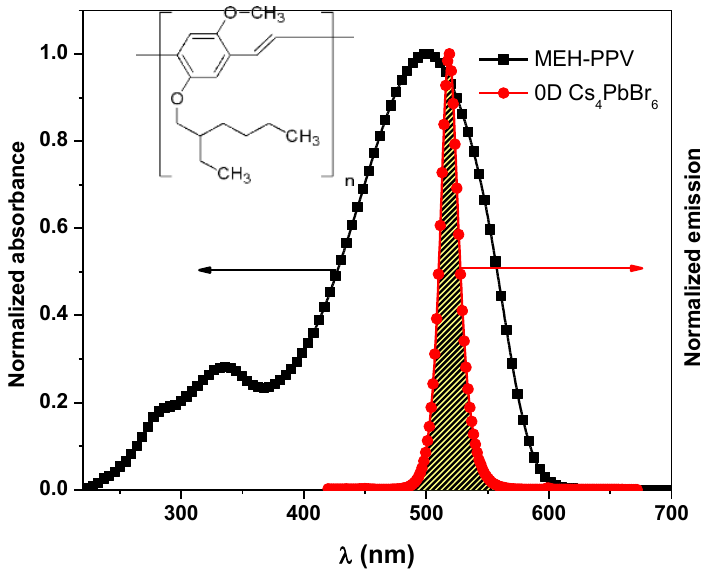
Figure 3. Overlapping between absorption and fluorescence spectra of MEH-PPV and 0-D Cs 4 PbBr 6 . Inset: chemical structure of MEH-PPV.